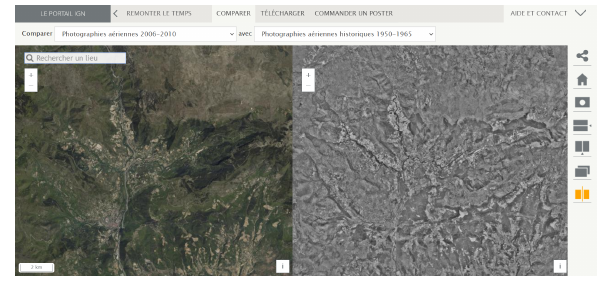
Figure 3. Screenshot of the website https://remonterletemps.ign.fr